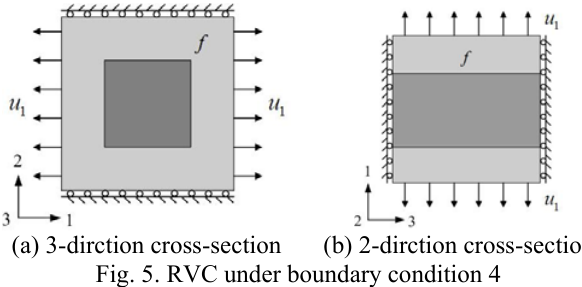
Fig. 5. RVC under boundary condition 4